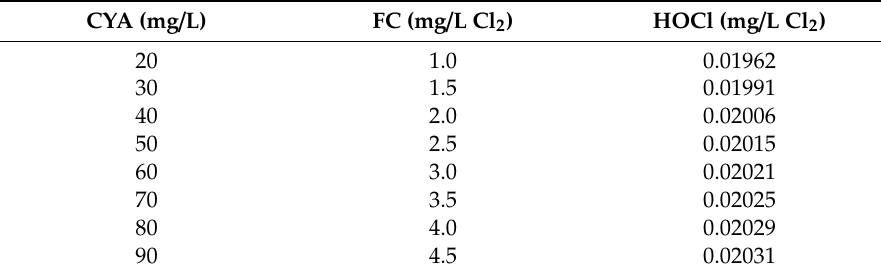
Table 3. HOCl at constant CYA / FC